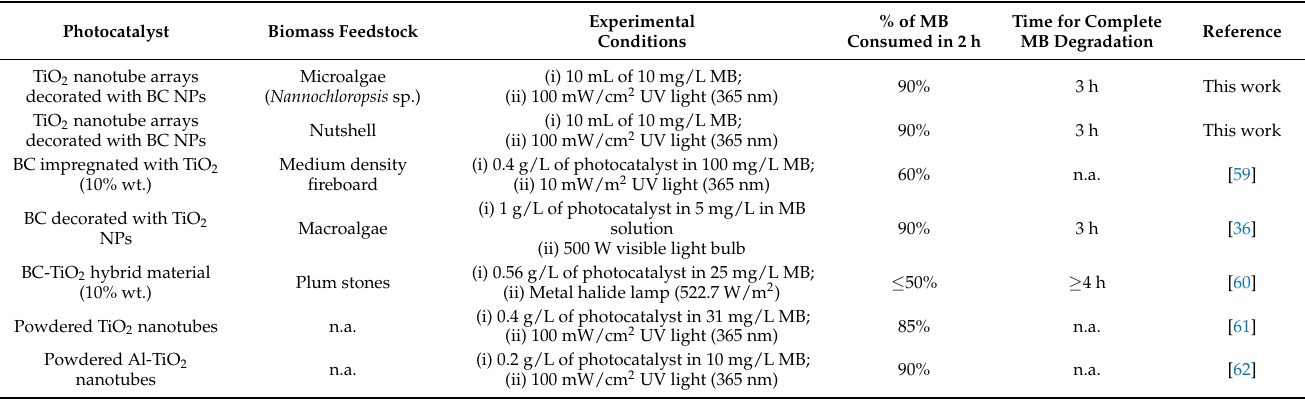
Table 1. Comparison of the photocatalytic performances towards MB degradation achieved in this work with those reported in the literature for other TiO 2 -BC composite